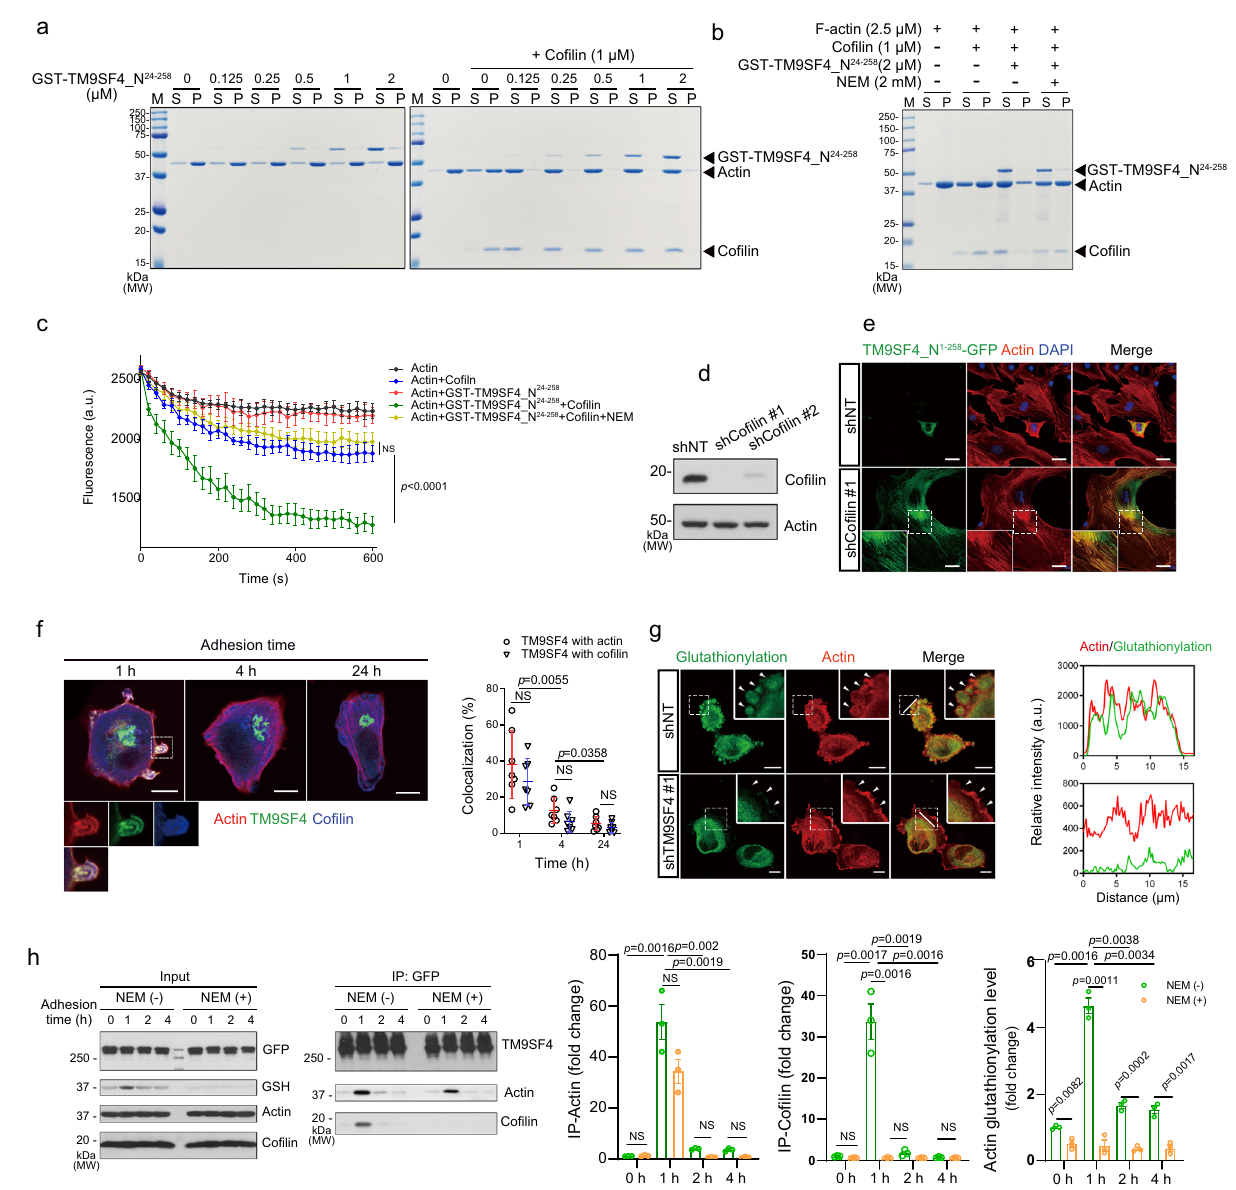
Fig. 4 | TM9SF4 NTF promotes co fi lin-mediated actin disassembly. a GST- TM9SF4_N 24 – 258 promoted co fi lin-mediated F-actin disassembly, as demonstrated by the shift of actin from pellet fraction (P, F-actin) to supernatant fraction (S, G- actin). b NEM treatment inhibited the action of GST-TM9SF4_N 24 – 258 in promoting co fi lin-mediatedactindisassembly. c Pyrene-actindepolymerizationassayshowing thatGST-TM9SF4_N 24 – 258 acceleratedco fi lin-mediatedactindisassembly,whichwas prevented by 2mM NEM. d , e Co fi lin is required for TM9SF4 NTF-induced F-actin disruption in NIH3T3 cells. The cells were stably transduced with lentivirus-based co fi lin-speci fi c shRNA(shCo fi lin #1),which couldeffectivelyknockdown the co fi lin expressionasinimmunoblots( d ).ScrambledshRNA(shNT)wasusedascontrol.In e , transient overexpression of TM9SF4_N 1 – 258 -GFP disrupted the F-actin fi bers in control cellsasmonitored by Rhodamine Phalloidin staining, but failed to do so in cellswithco fi linknockdown.Scalebar=10 μ m. f Time-dependentcolocalizationof TM9SF4, actin and co fi lin at cell peripheral region of GFP-TM9SF4 overexpressing A2780 cells. Actin was monitored by Rhodamine Phalloidin staining, and co fi lin